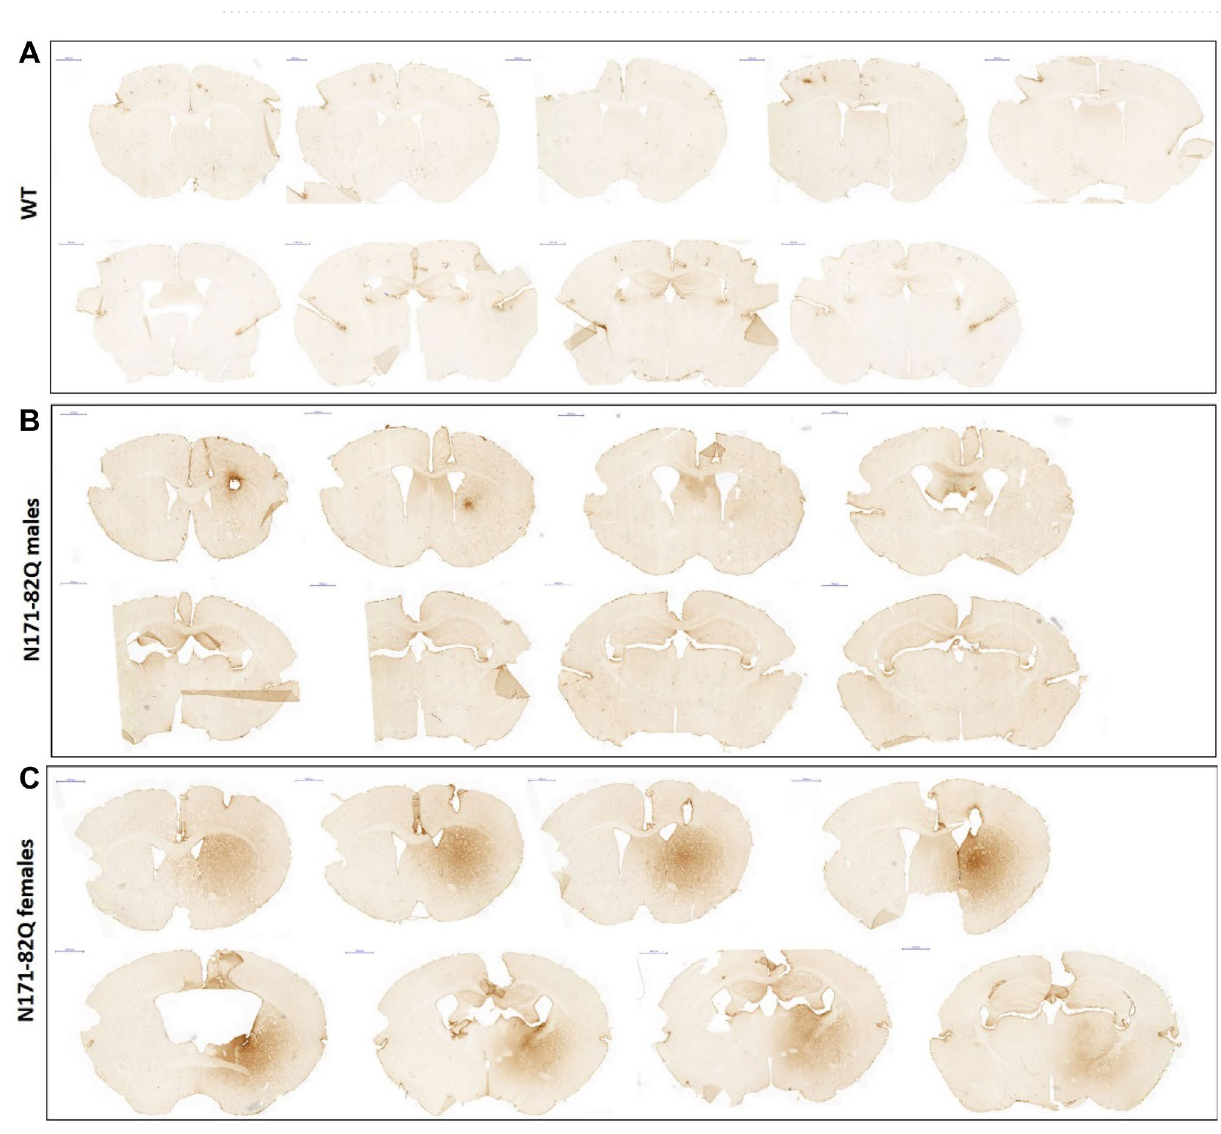
Figure 2. Diffusion of CDNF after chronic intrastriatal administration into N171-82Q mouse model (free-floating sections). Mice received an intrastriatal 4-week chronic infusion (A/P + 0.86; M/L − 1.8; D/V − 3.0) of CDNF (3 μg per 24 h). Immunohistochemical CDNF staining showed the CDNF distribution across the brain in WT animals (control, uninfused) ( A ), N171-82Q male mice ( B ), and N171-82Q female mice ( C ). Scale bar: 1000